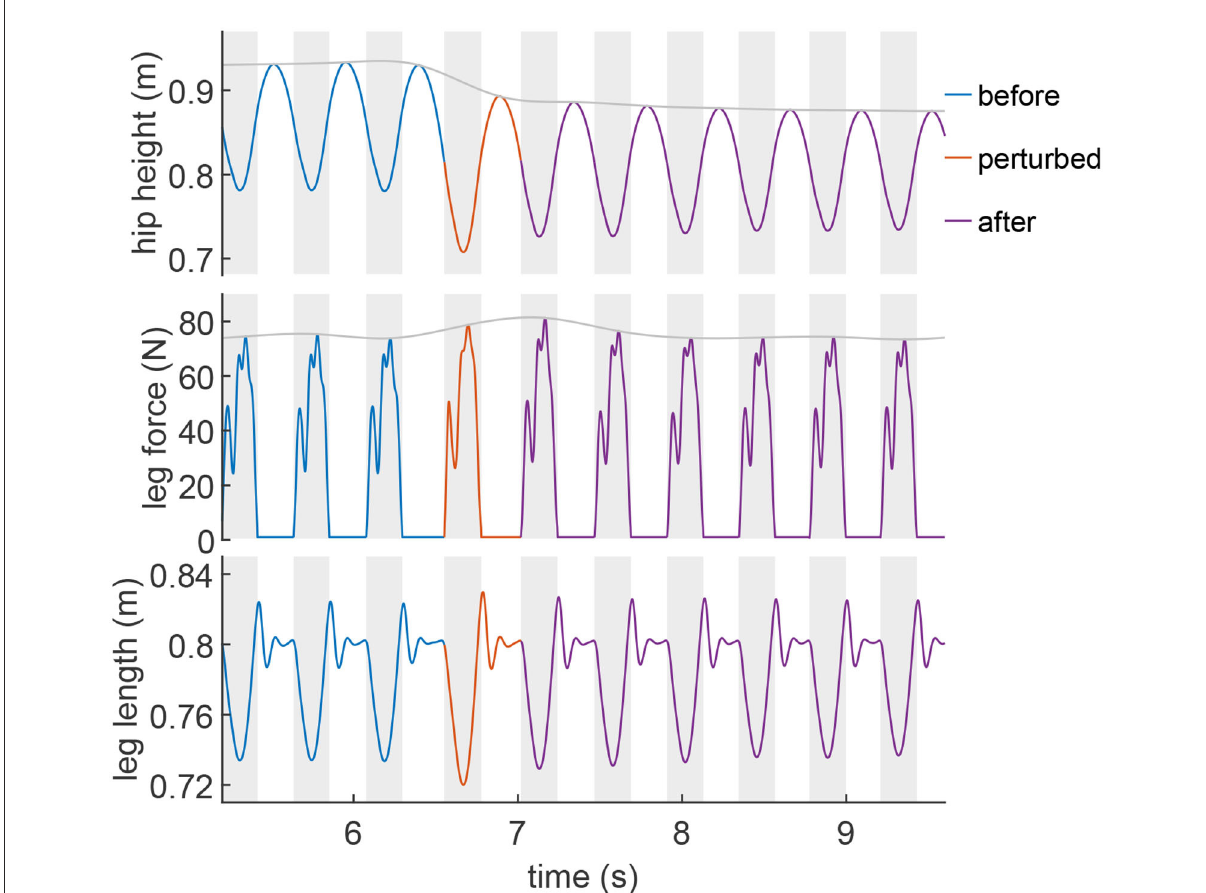
FIGURE3 Example of the measured hip height, leg force, and leg length of EPA-Hopper during a perturbed hopping experiment ( P se = 0.4MPa, P ext = 0.5MPa, P fle = 0.6MPa). The perturbed hop is shown in orange. The blue and velvet colors denote the hops before and after the perturbed hop. Gray shaded areas denote the stance phases.